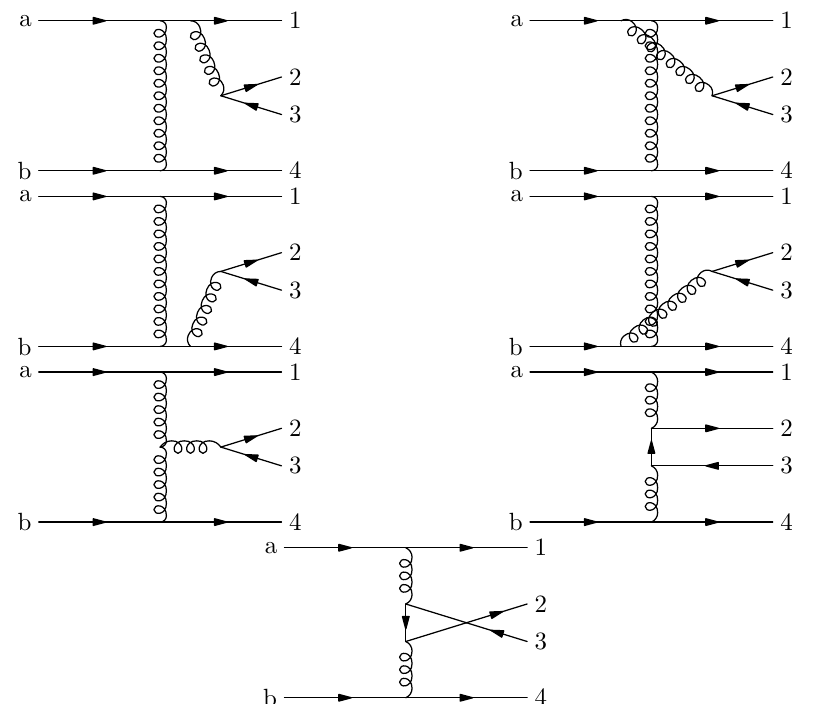
¯ Q ˜ q at leading order. = P )¯ u h ( p ) u h ( p i i h i